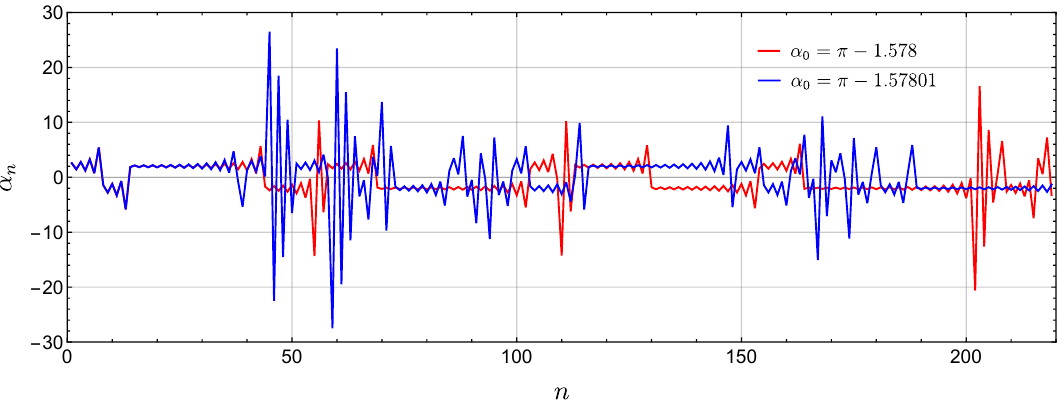
Figure 11 . The patten of α generated by the transformation rule (3.22) due to the Kanser transition and the Kanser inversion. The initial value of α is chosen to be α α 0 = π − 1 . 57801 (blue). It is clear that a slight difference in initial values causes significant changes after about n = 43 times alternation of Kasner